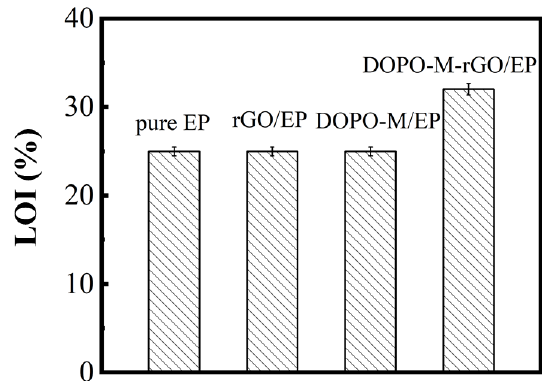
Figure 4. LOI values of the pure EP, rGO/EP composite, DOPO-M/EP composite, and DOPO-M- rGO/EP composite (the mass fractions of additive in the composites are all 1.5%).